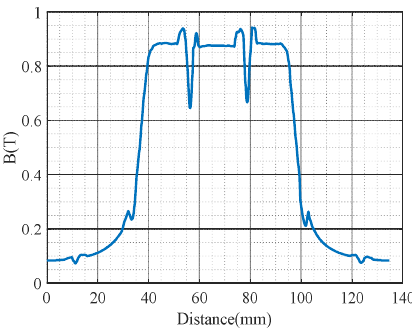
Figure 4. The main flux path in no-load operation.